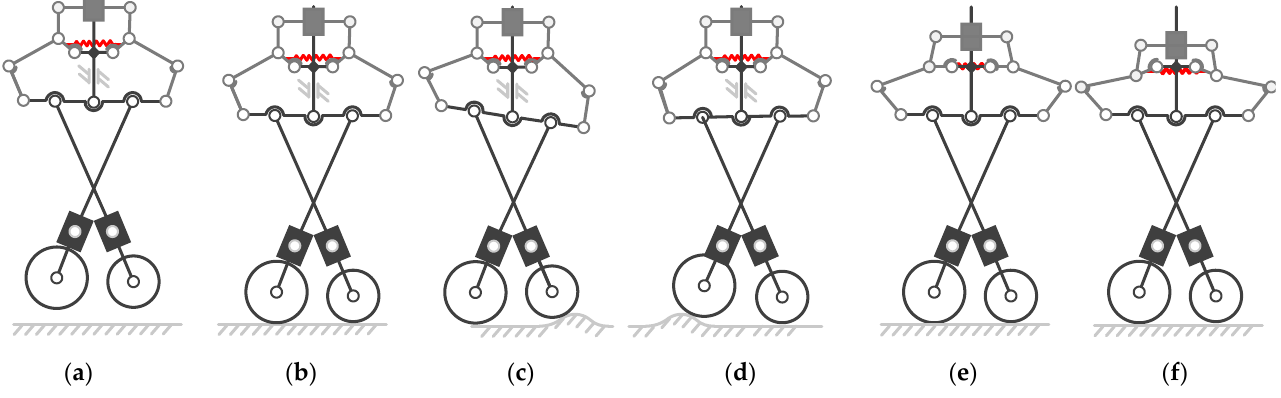
Figure 4. Conforming movement of the compaction mechanism in which ( a – d ) describe how the mechanism conforms to an arbitrary surface passively in compliant state, while ( e , f ) describe the transformation from compliant state to stiff state for sheet manufacturing.